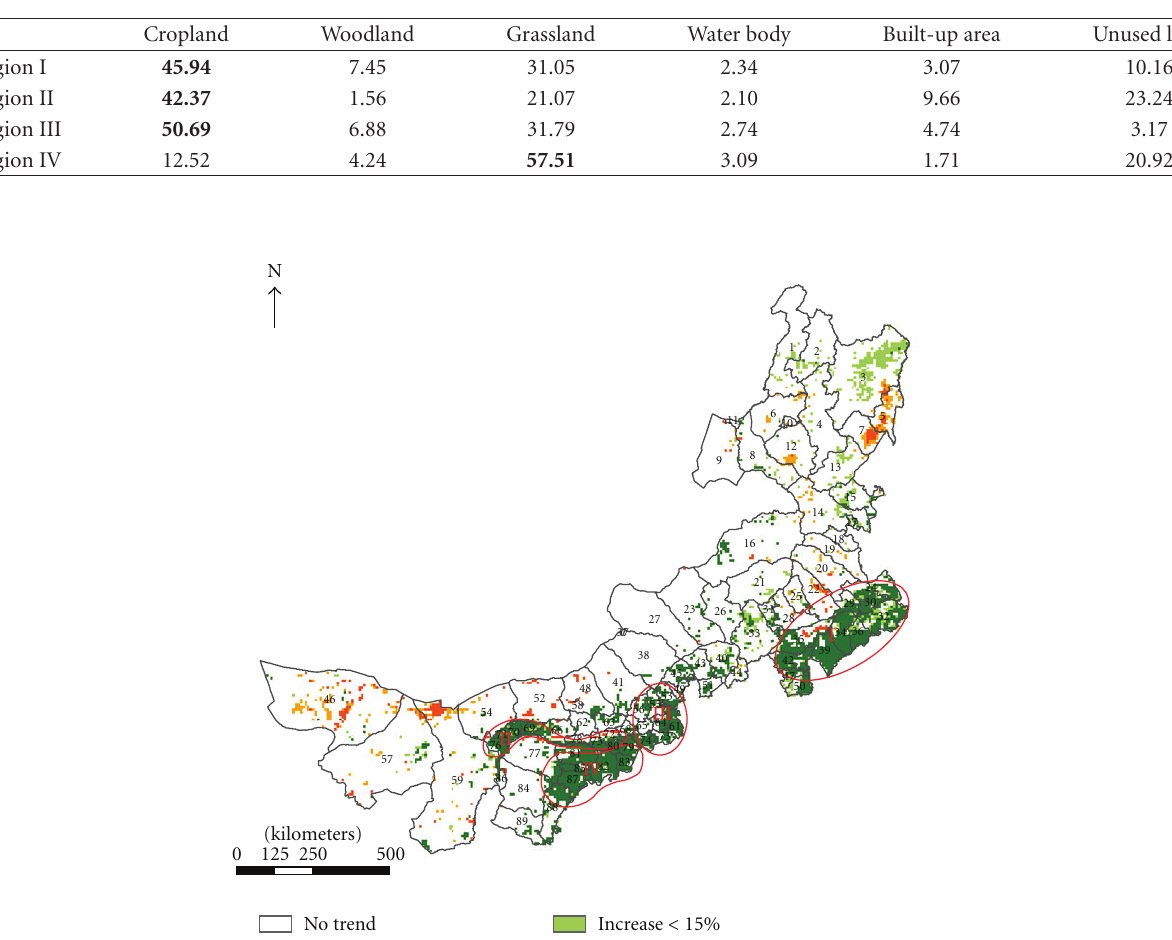
Table 3: The percentage of di ff erent land uses to the total area in the regions where NDVI had strong increasing trends (%).